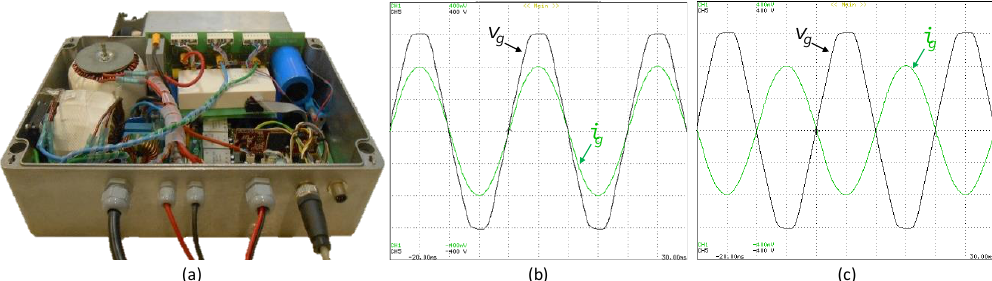
Figure 5. On-board EVBC: ( a ) example of a developed laboratory prototype; ( b ) experimental results during the grid-to-vehicle (G2V) mode ( v g : 100 V/div/ i g : 10 A/div | 5 ms/div); ( c ) Experimental results during the vehicle-to-grid (V2G) mode ( v g : 100 V/div/ i g : 10 A/div | 5 ms/div).